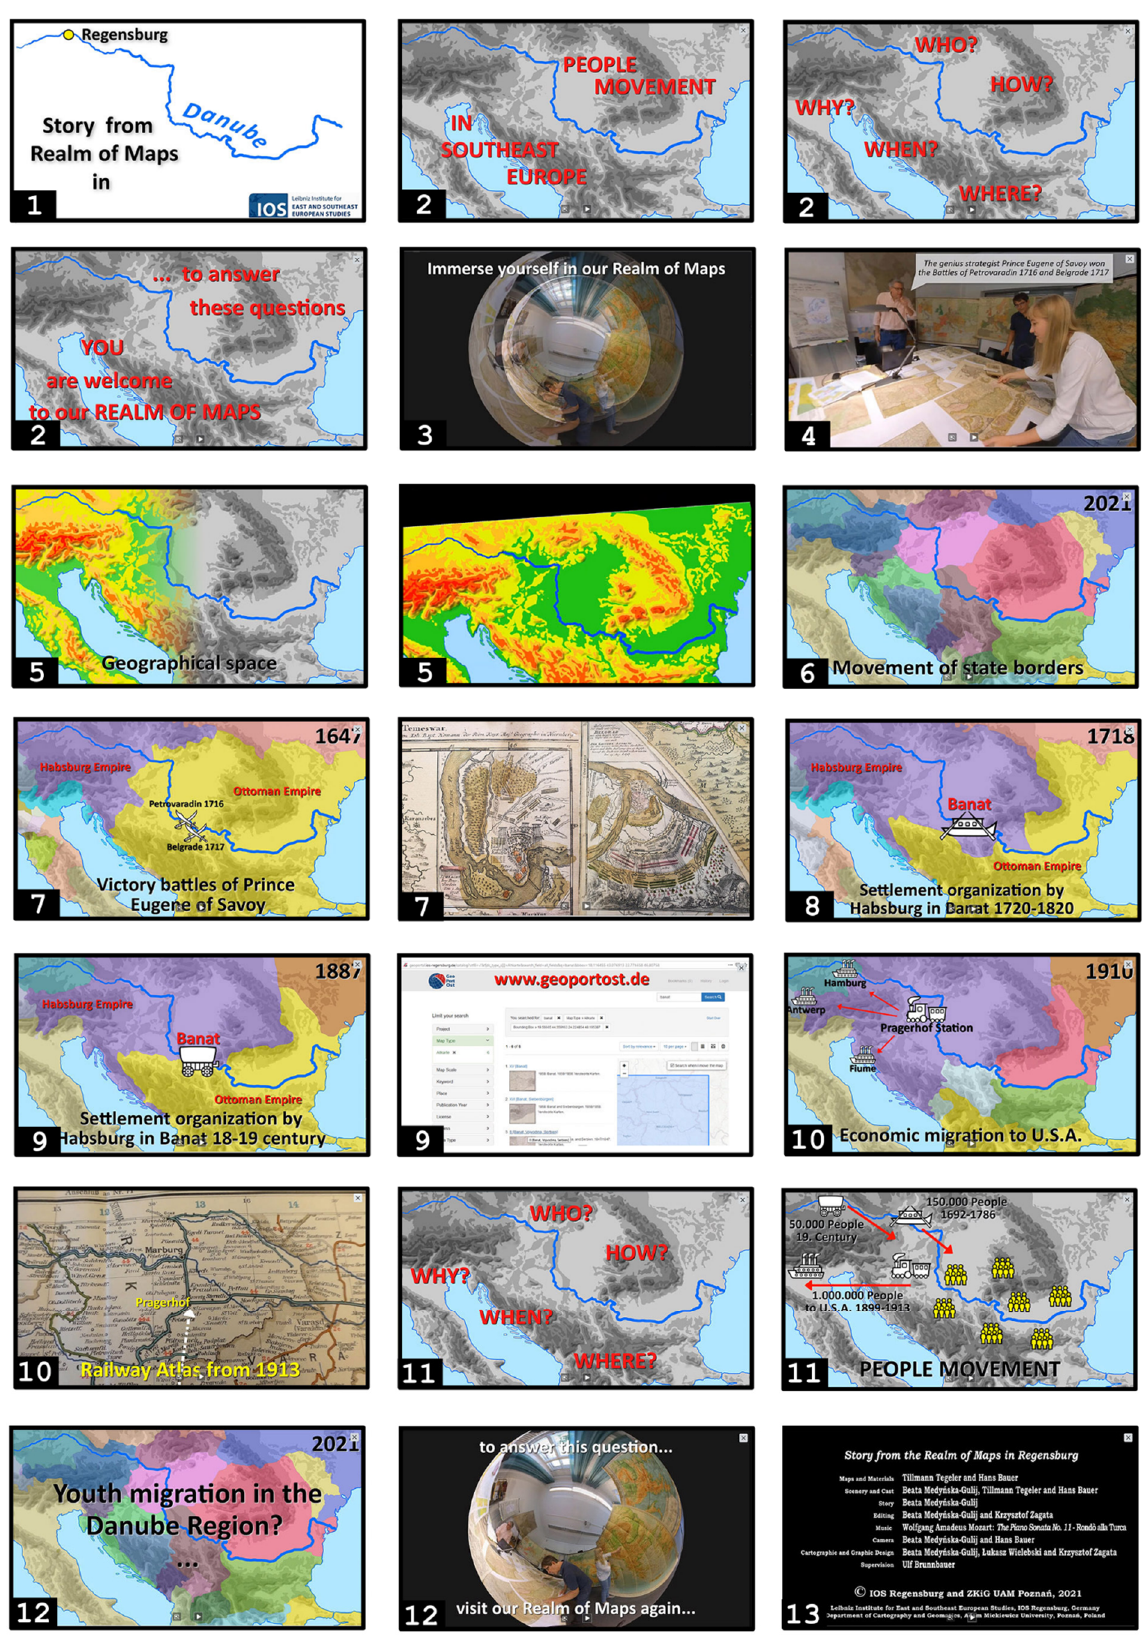
Figure 4. A total of 13 sequences of the film, whose frames are graphically depicted.